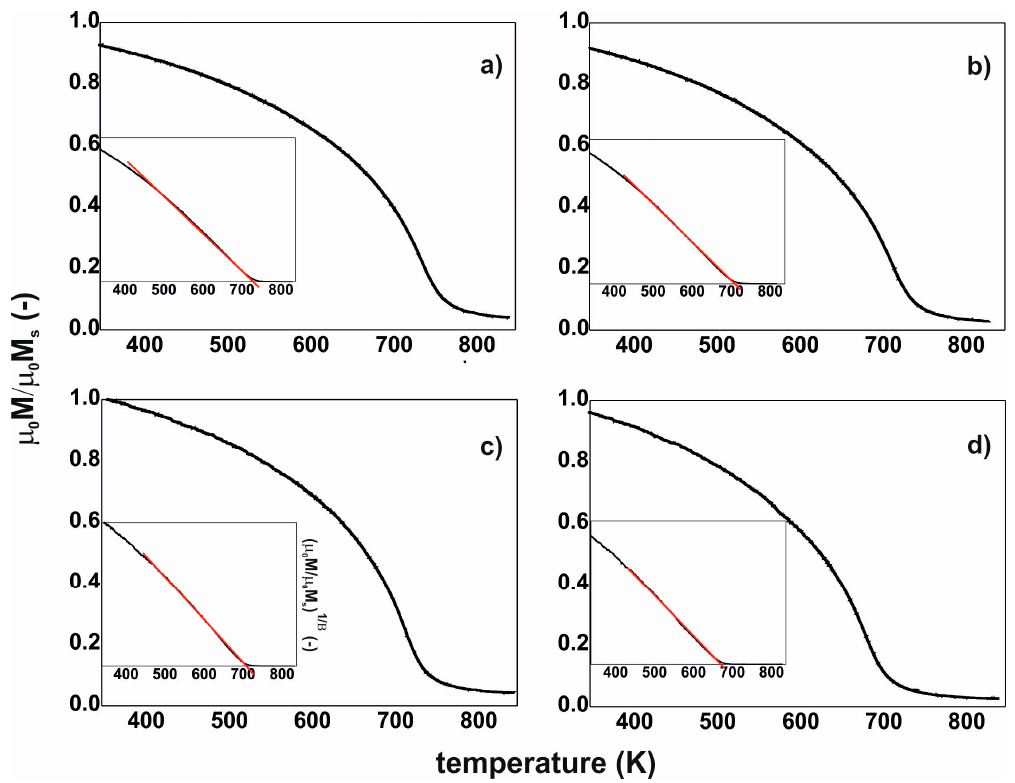
Figure 4. Magnetic saturation polarisation curves, as a function of temperature: ( a ) Fe 36 Co 36 Y 8 B 20 , ( b ) Fe 39 Co 33 Y 8 B 20 , ( c ) Fe 43 Co 29 Y 8 B 20 , ( d ) Fe 48 Co 24 Y 8 B 20 .